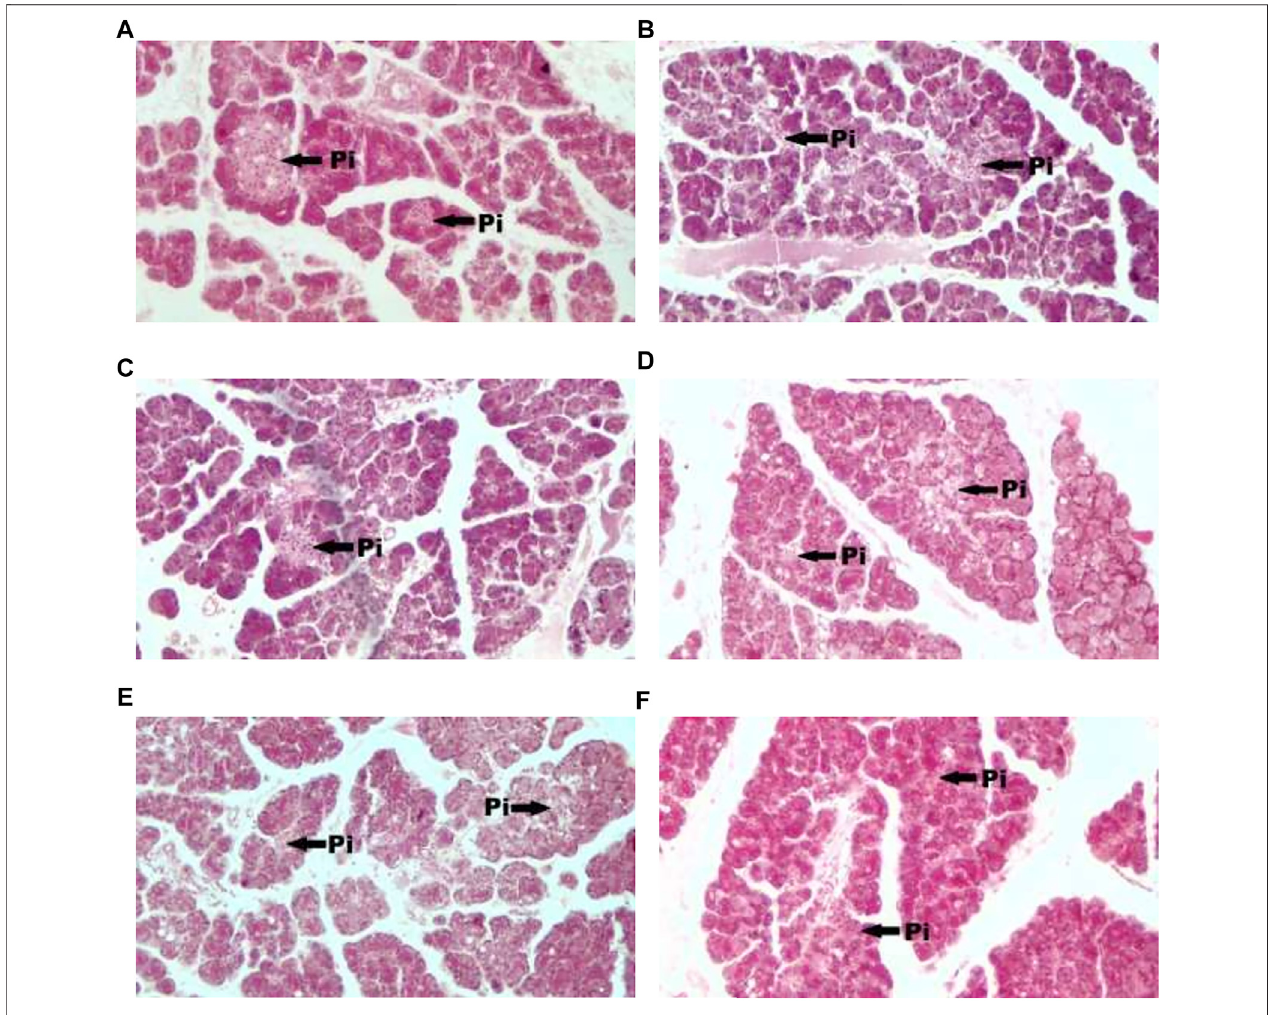
FIGURE 1 | Photomicrograph of a section of pancreas of normal control (A) , diabetic control (B) , glibenclamide 20 mg/kg (C) , Spondias mombin 125 mg/kg (D) , Spondias mombin 250 mg/kg (E) , Spondias mombin 500 mg/kg (F) . PI-Pancreatic Islet. H&E 100X.